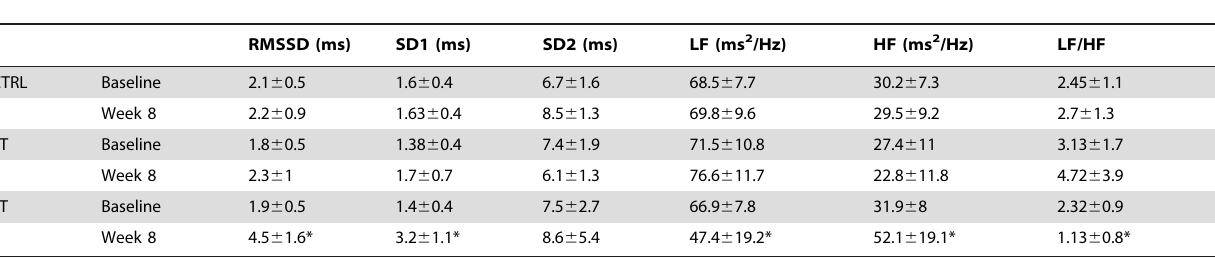
Table 5. Heart Rate Variability (HRV)